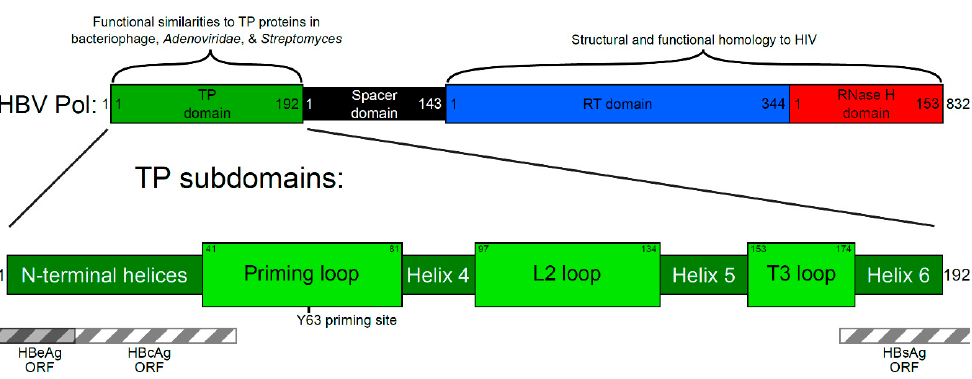
Figure 1. Schematic representation of hepatitis B virus polymerase domains and terminal protein (TP) subdomains. The polymerase protein is responsible for DNA synthesis, which is carried out by the catalytic reverse transcriptase (RT) domain. While the RNA template is copied into viral DNA, the RNase H domain degrades the RNA template. The TP domain acts as a primer for the initial DNA synthesis steps, and the DNA remains attached to the TP domain throughout synthesis. The spacer domain is thought to allow for flexibility while the TP is attached at one end of the nascent viral DNA and the RT domain synthesizes the other end. Regions of similarity with other proteins are highlighted. Within the TP domain (green), the function of the helical subdomains is likely to provide structure, while the loop subdomains are involved in activities critical to the viral replication cycle, such as protein priming that initiates from the tyrosine at position 63 (Y63). The regions of the TP domain that overlap with other open reading frames (ORF) are shown as striped boxes. These regions are under additional selection pressure when mutations occur. HBV: hepatitis B virus; HIV: human immunodeficiency virus; Pol: polymerase.